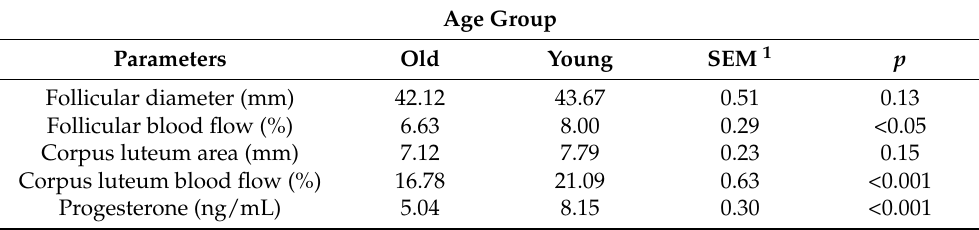
Table 2. Least squares mean of ultrasonic parameters and progesterone